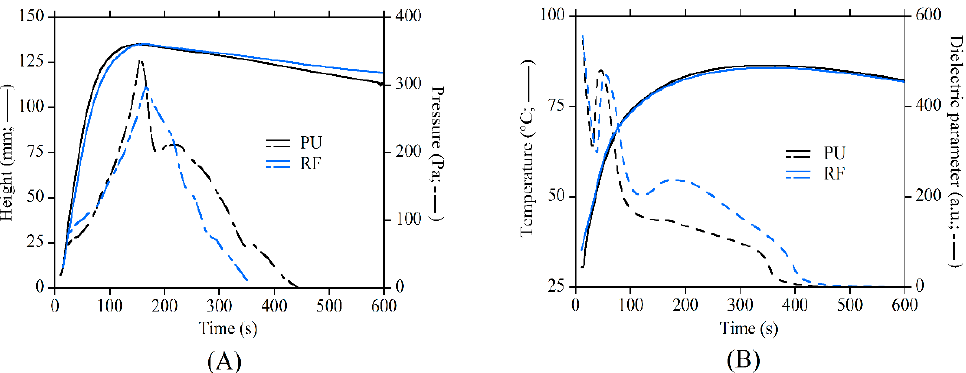
Figure 3. Comparison of the processing parameters from the FOAMAT instrument recorded during the foaming of the PU